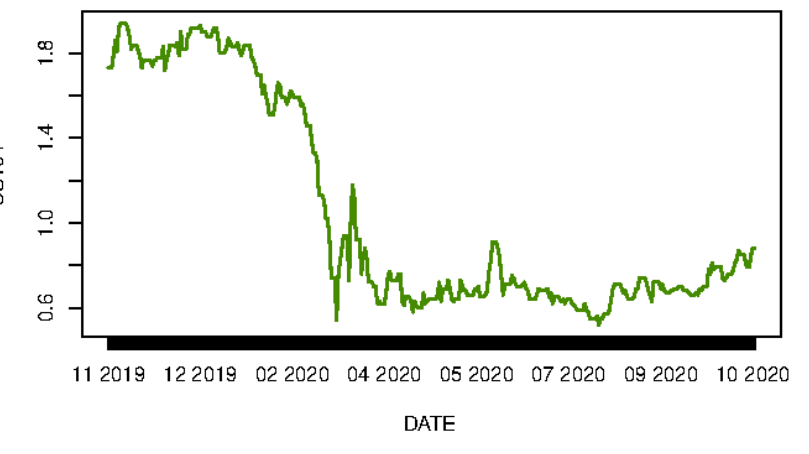
Figure 1. S&P 500 (SP _ 500). FRED—Federal Reserve Bank of St. Louis. The pandemic shock was transmitted to the US bond markets as well, whose returns remained low in a quantitative-easing era from the Fed (Figure 2).